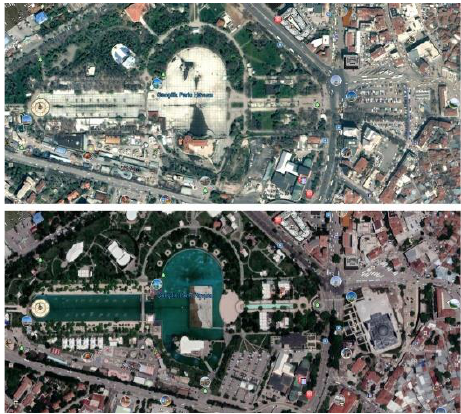
Figure 2: Google Earth images of the park and Hergelen square in 2002 (above) and (2017) below.